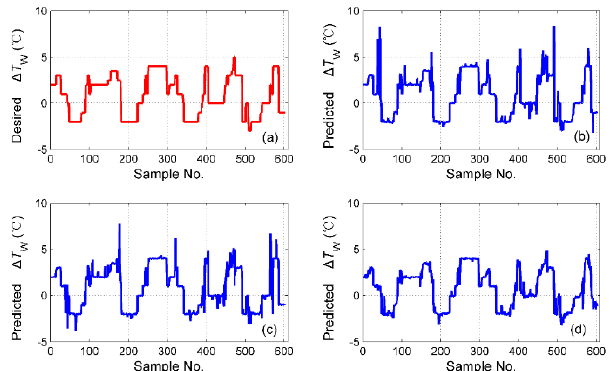
Figure 20. The simulation results of ∆ T W for di ff erent fusion schemes, namely: ( a ) desired ∆ T W ; ( b ) predicted ∆ T W for feature level data fusion; ( c ) predicted ∆ T W for decision level data fusion; ( d ) predicted ∆ T W for hybrid multi-sensor data fusion.